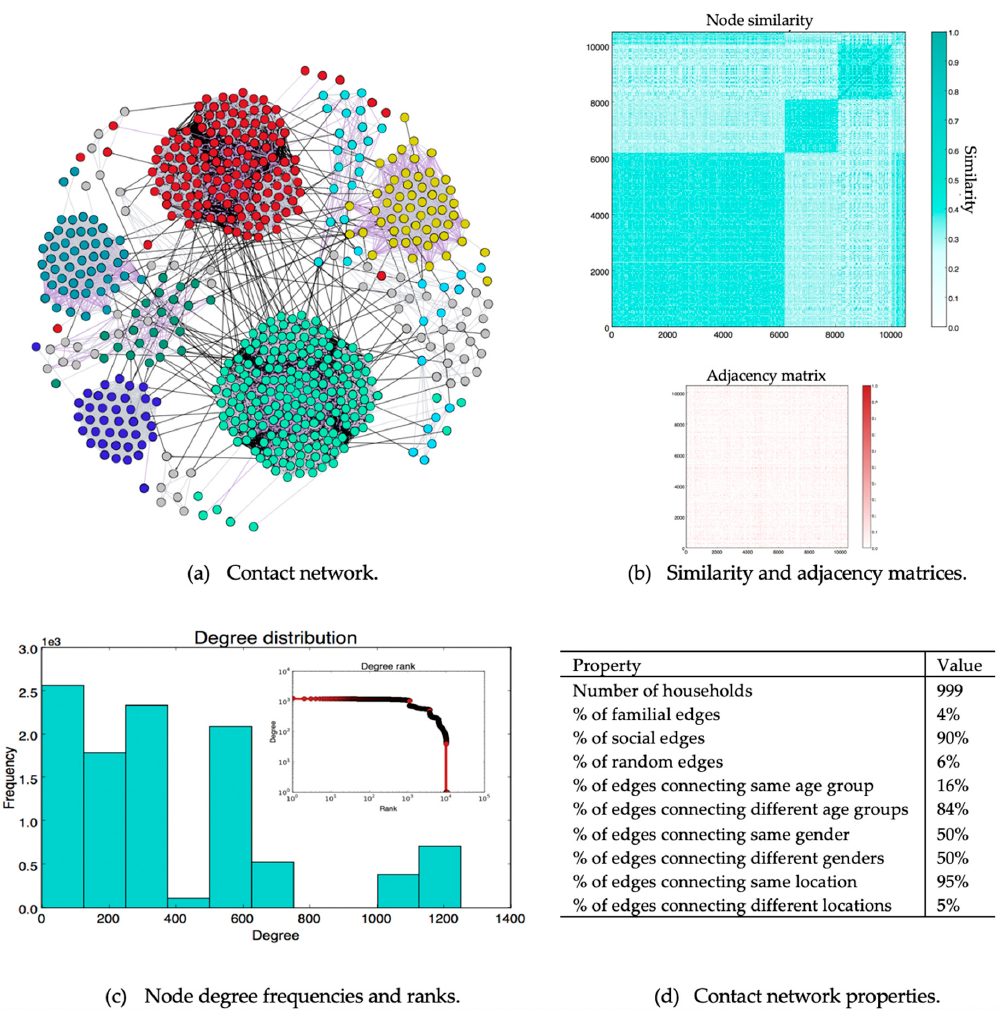
Figure 2. Generated contact network information. ( a ) Part of the generated contact network showing contact relationships between 50 randomly selected households. The gray edges are familial, the purple edges are social, and the black edges are random. ( b ) Similarity and adjacency matrices. Each cell in the adjacency matrix indicates the existence (dark cell) or the absence (white cell) of an edge between each node pair. ( c ) Degree distribution. ( d ) General network properties.